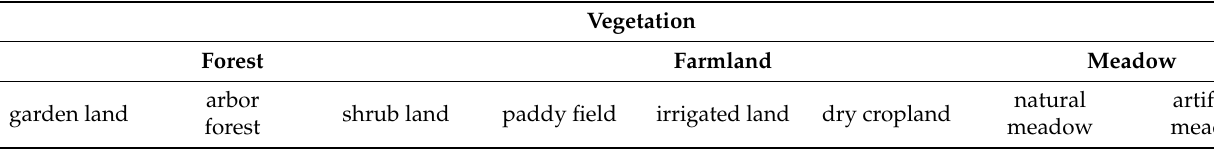
Table 1. The 8 vegetation subclasses in the GID dataset.